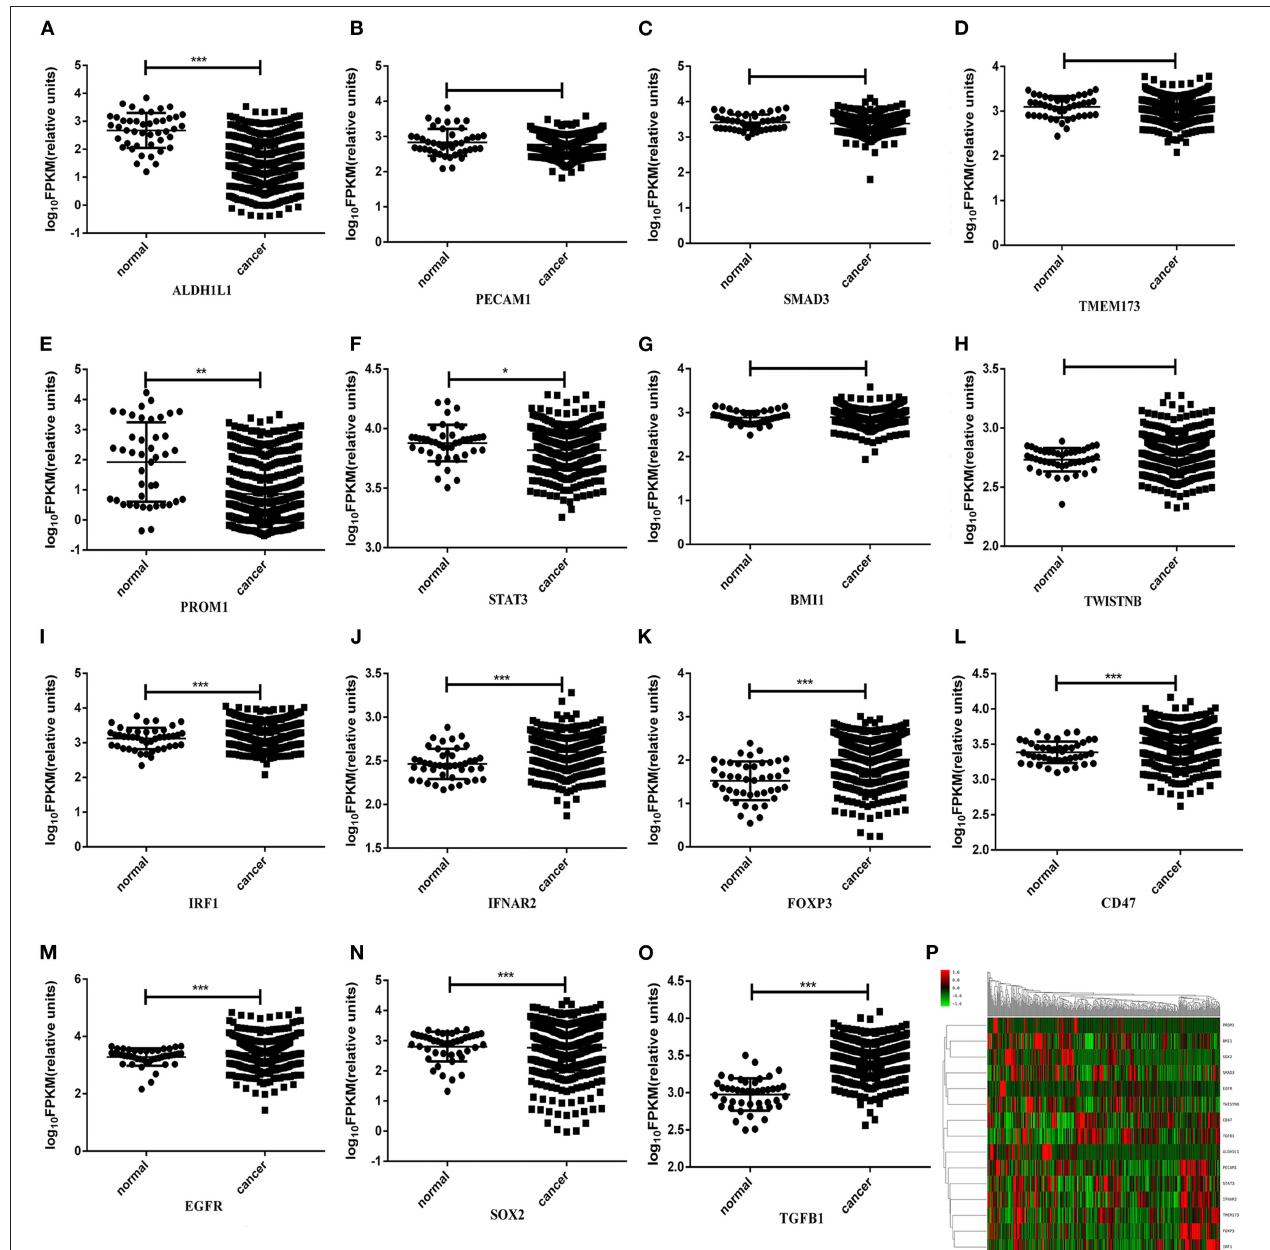
FIGURE 1 | FPKM values of ALDH1L1 (A) , PECAM1 (B) , SMAD3 (C) , TMEM173 (D) , PROM1 (E) , STAT3 (F) , BMI-1 (G) , TWISTNB (H) , IRF1 (I) , IFNAR2 (J) , FOXP3 (K) , CD47 (L) , EGFR (M) , SOX2 (N) , and TGF β 1 (O) expression of HNSCC patients in TCGA datasets; (P) Heatmap of gene expression profiles of HNSCC patients in TCGA datasets. Gene expression values are calculated based on the log transform of FPKM values determined from RNA sequencing analyses. High expression is depicted by red; low expression is depicted by green, normalized by row z scores (legend). * P < 0.05, ** P < 0.01, *** P <